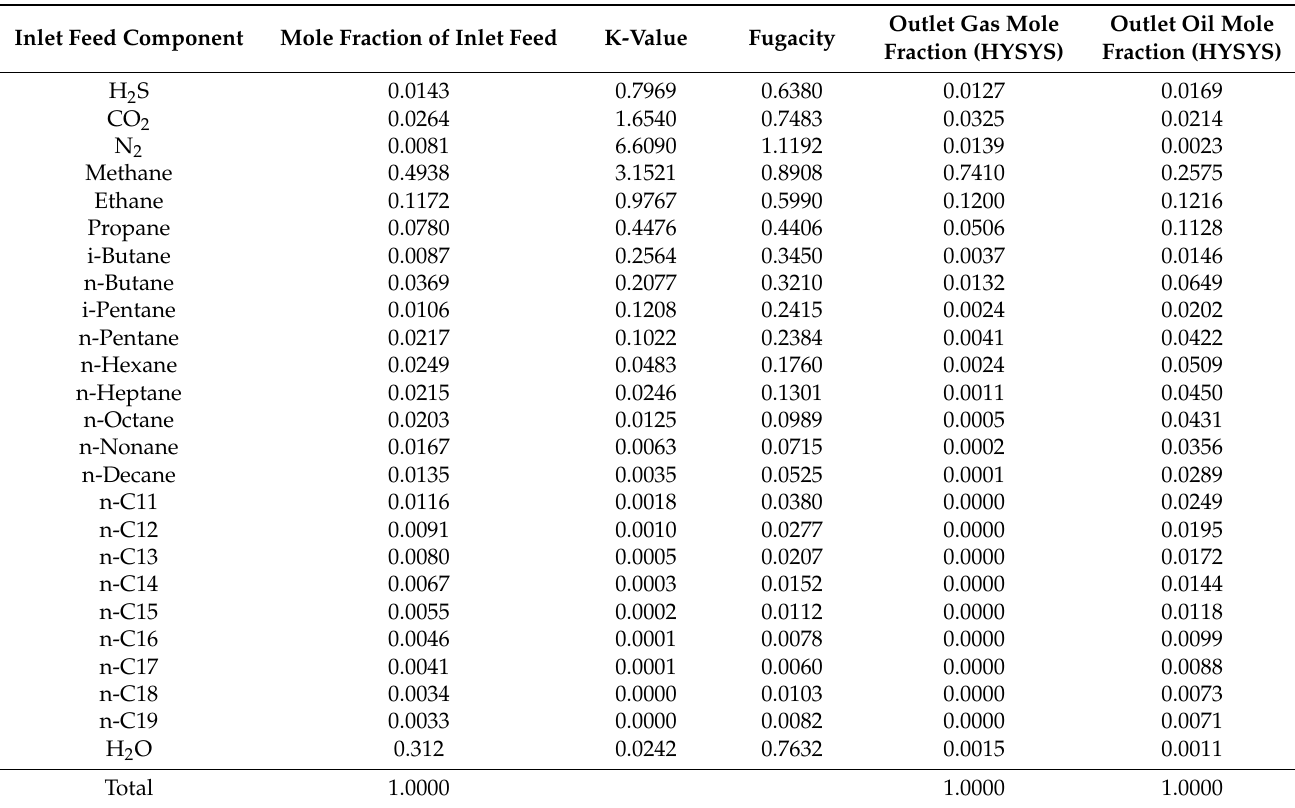
Table 1. Composition of feed stream and its component mole fractions, K-values, fugacity, mole fraction of the gas outlet stream and oil outlet